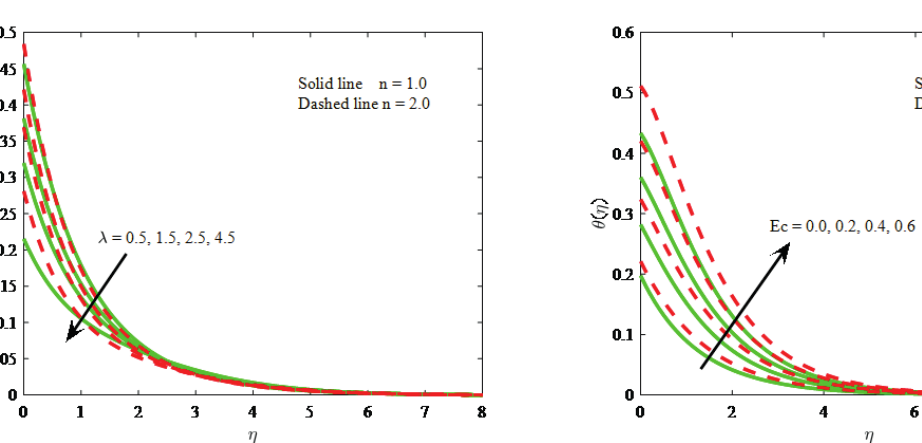
Fig. 9: Impact of λ on micro-rotation velocity.